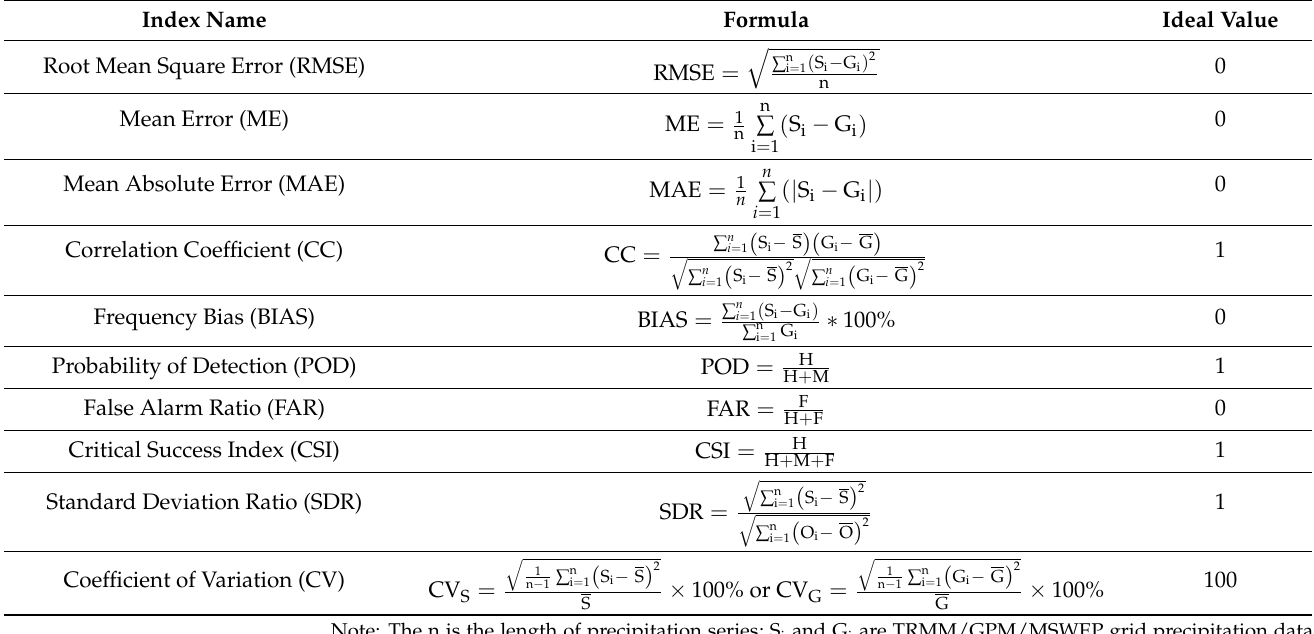
Table A1. Precision evaluation indexes of precipitation products.